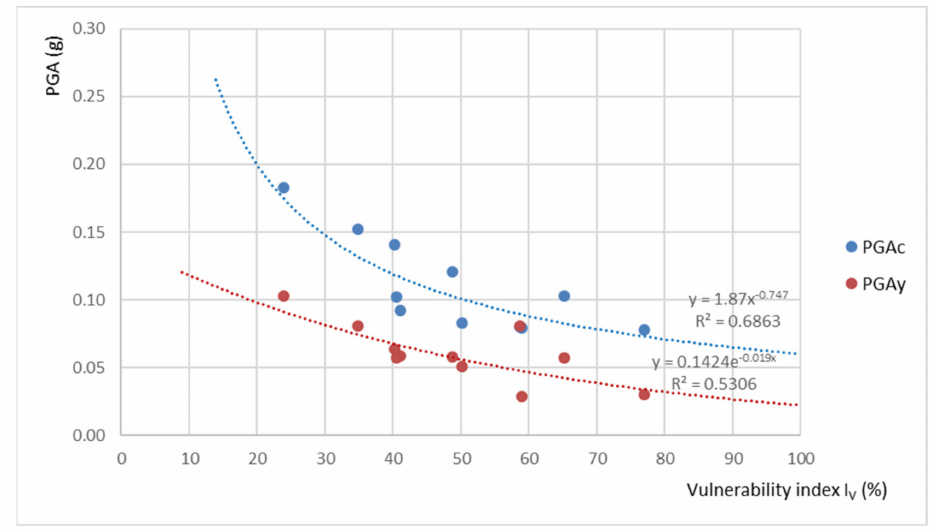
Figure 16. Trend lines I v –PGA y and I v –PGA c .